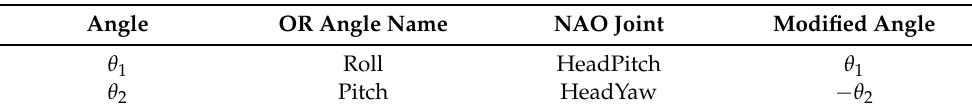
Figure 18. Head joint of the NAO robot [27]. Table 3. NAO head